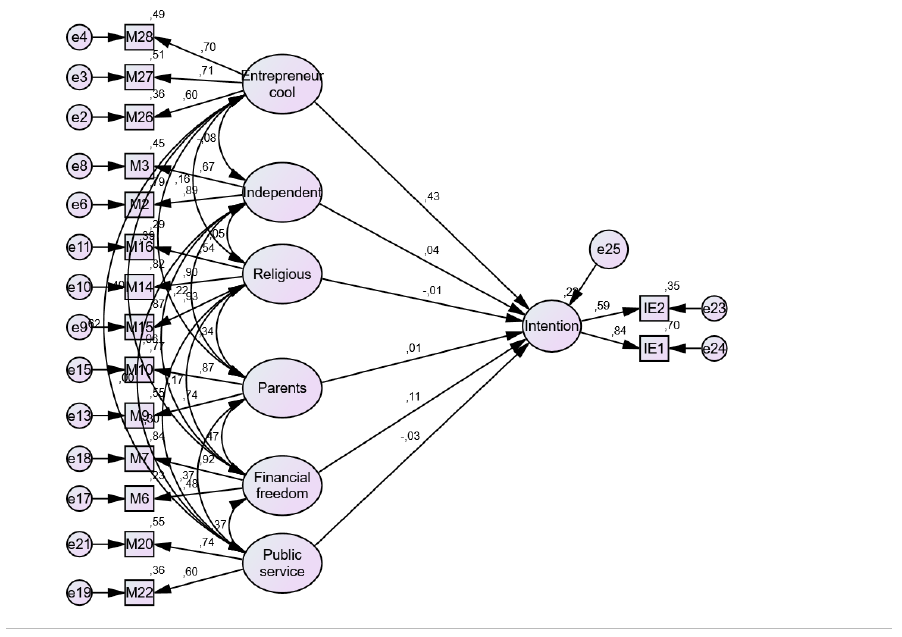
Figure 1. The structural model of the first model